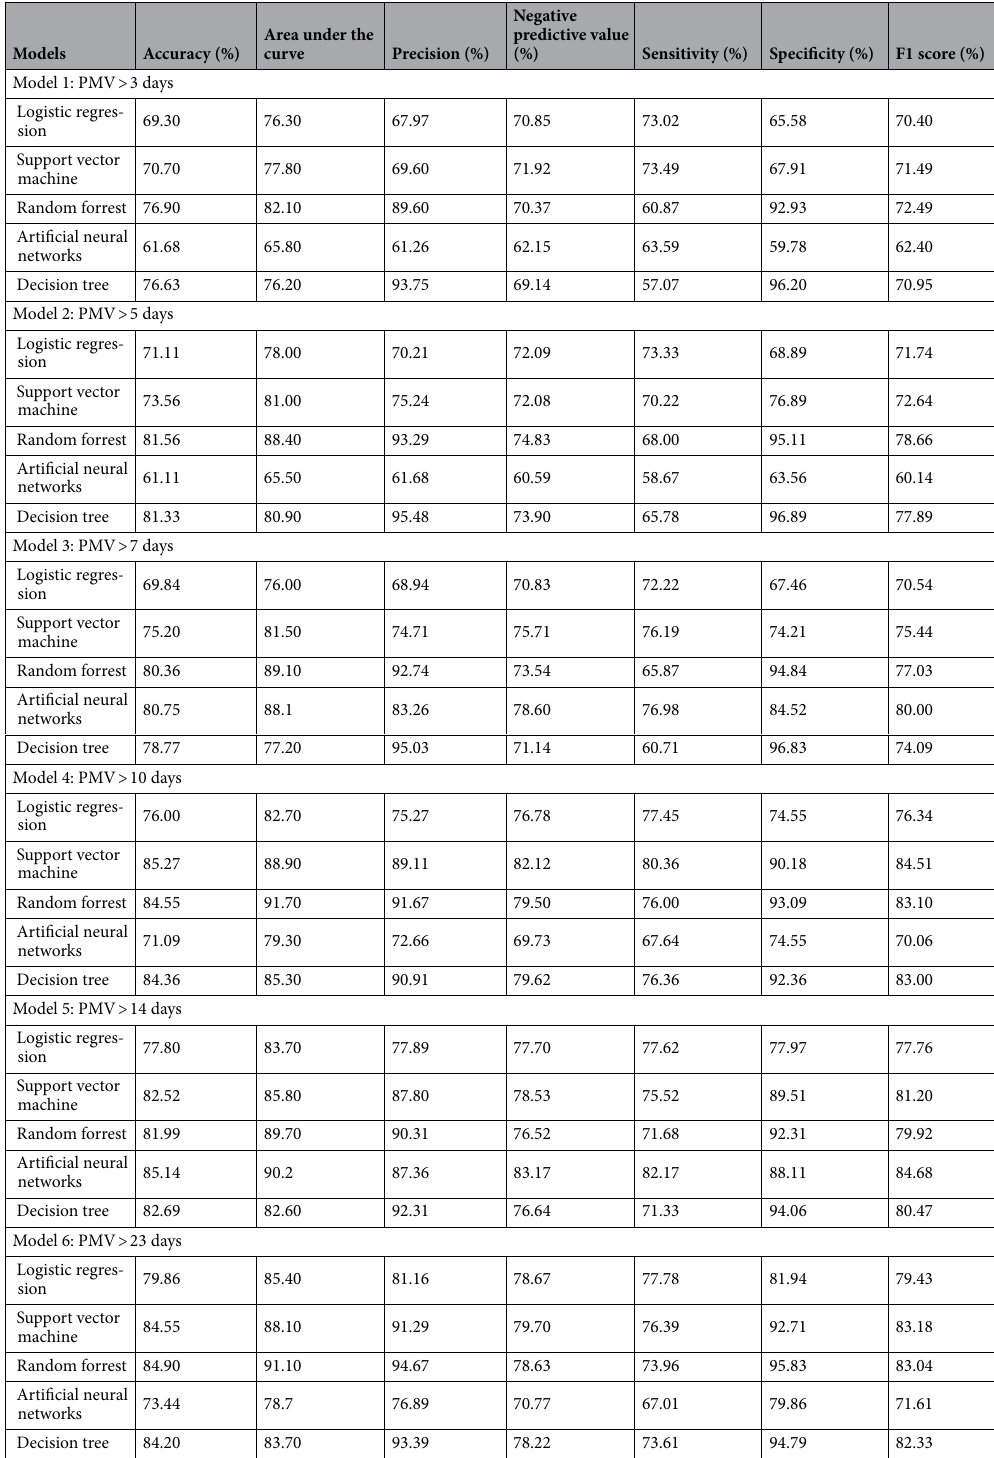
Table 1. Performance of the prediction models. PMV prolonged mechanical